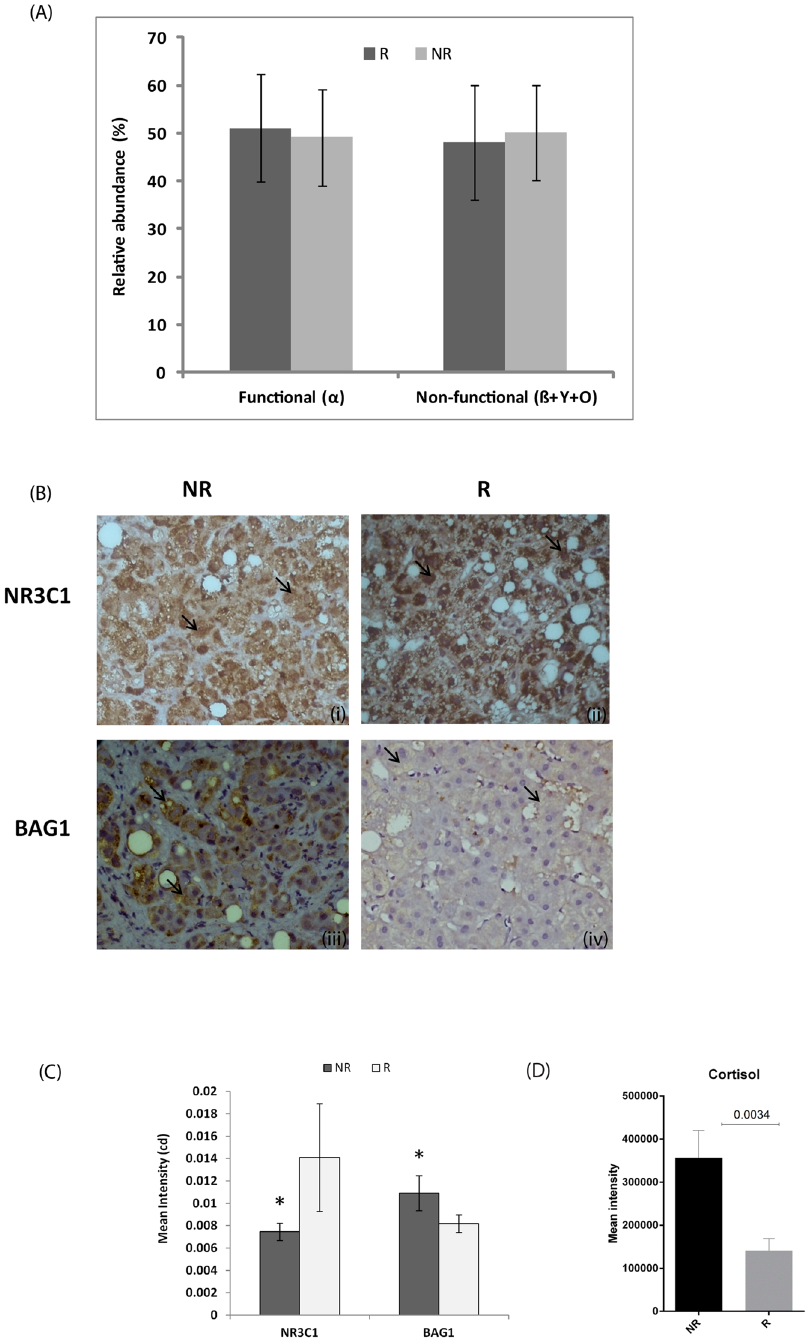
Figure 3. Expression of NR3C1 transcript variants and its protein among Indian NR and R. ( A ) The functional and non-functional transcript variants in R and NR were not significantly distinct. ( B ) The GR degrading protein BAG1 correlates with reduction in the NR3C1 in liver biopsy sections (40 × ): (i) and (ii) are biopsy sections from NR and R respectively, stained with NR3C1 antibody; (iii) and (iv) are sections from NR and R respectively stained with BAG1 antibody. Arrows indicate the presence of respective proteins in the cells. ( C ) Quantitation of the chromogenic signal from the anti-BAG1 and anti-NR3C1 antibodies confirms an increase in BAG1 and significant reduction in GR protein among NR. ( D ) Histogram showing the comparative values of cortisol (in terms of mean intensities as measured by mass spectrophotometer) for NR and R. * Indicates a significance value of P <